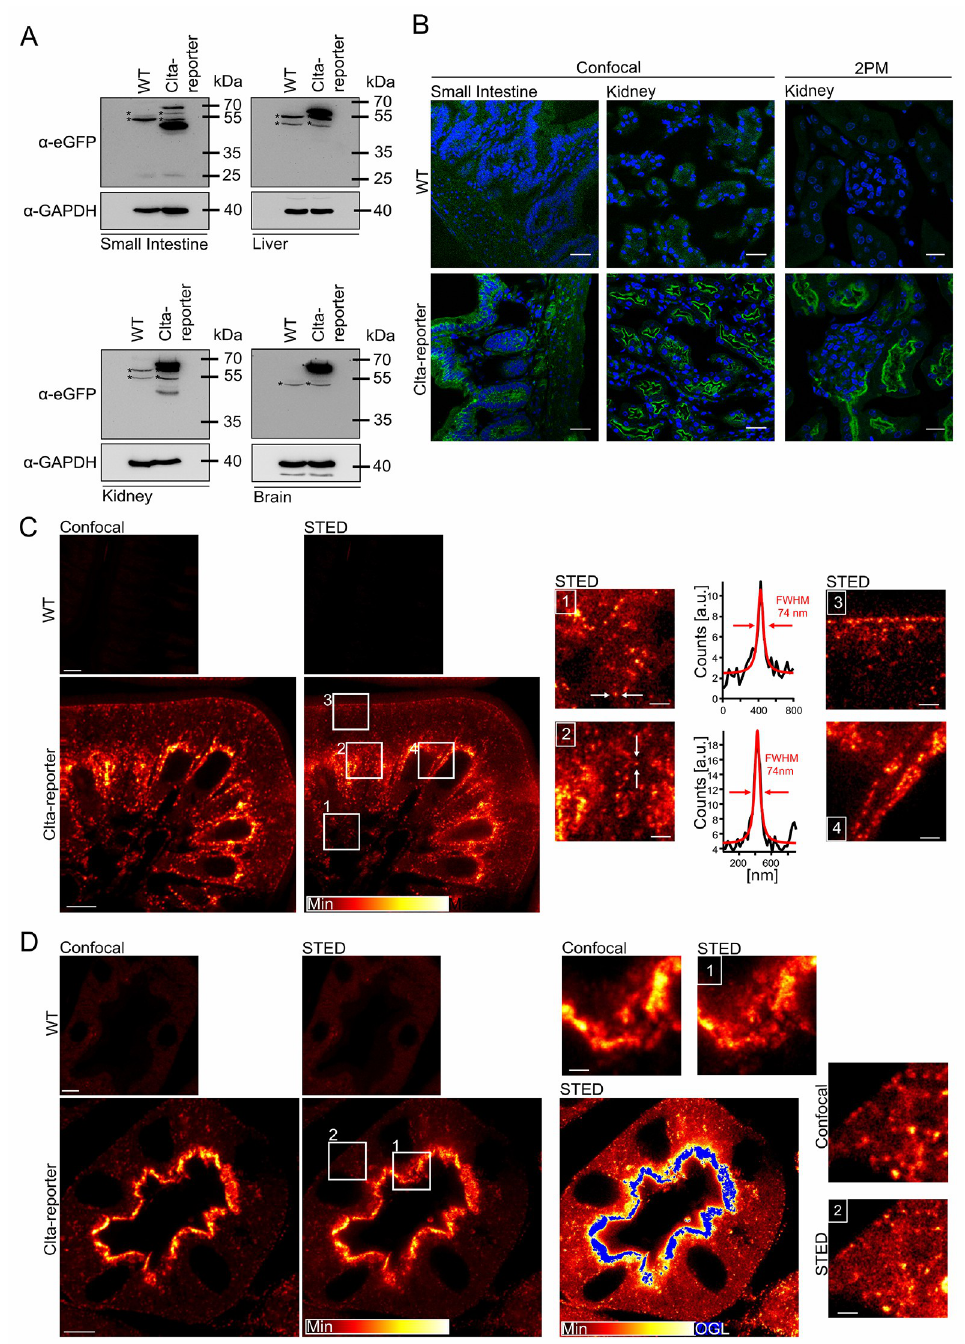
Fig 2. Tissue expression of Clta-eGFP fusion protein. ( A ) Western Blot Analysis of small intestine, brain, kidney and liver lysates show the expression of the Clta-eGFP fusion protein. Additional band in small intestine and kidney arises possibly through tissue specifc splicing or exon-skipping through insertion of eGFP. Partial degradation may not be excluded. On each lane 25 μ g of total protein were loaded. � : unspecific cross reactivity of the eGFP antibody. ( B ) Immunofluorescence of dye separated WT and Clta-reporter cryo sections of kidney and small intestine using confocal microscopy ( left , scale bar 30 μ m) and 2-PM ( right , scale bar 15 μ m). The related WT emission spectra in the green spectral range recorded with confocal microscopy, indicating an autofluoresence maxima at 550 nm can be found in S3B Fig in S1 Appendix. ( C ) Confocal and associated STED images of small intestine of WT and Clta-reporter cryo sections revealed a strong apical occurrence. Scale bar: 5 μ m and 1 μ m for the cut-outs (1–4). Clta-eGFP appears in clusters of 74